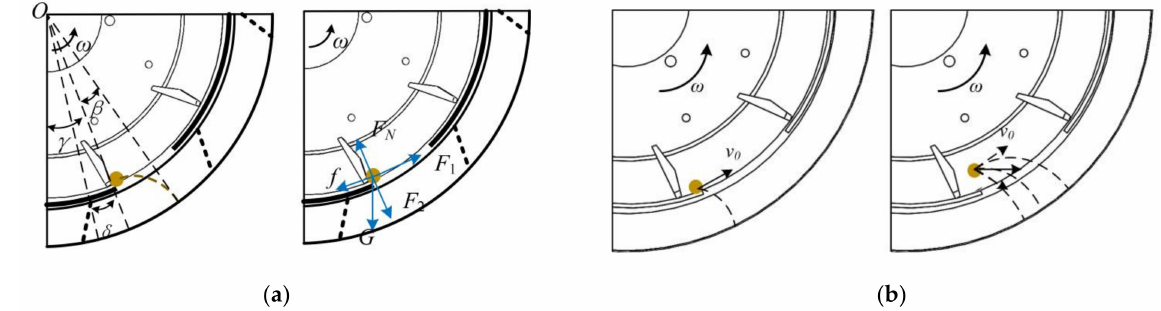
Figure 4. Two forms of leaving the dibbler cover: ( a ) contact; ( b )